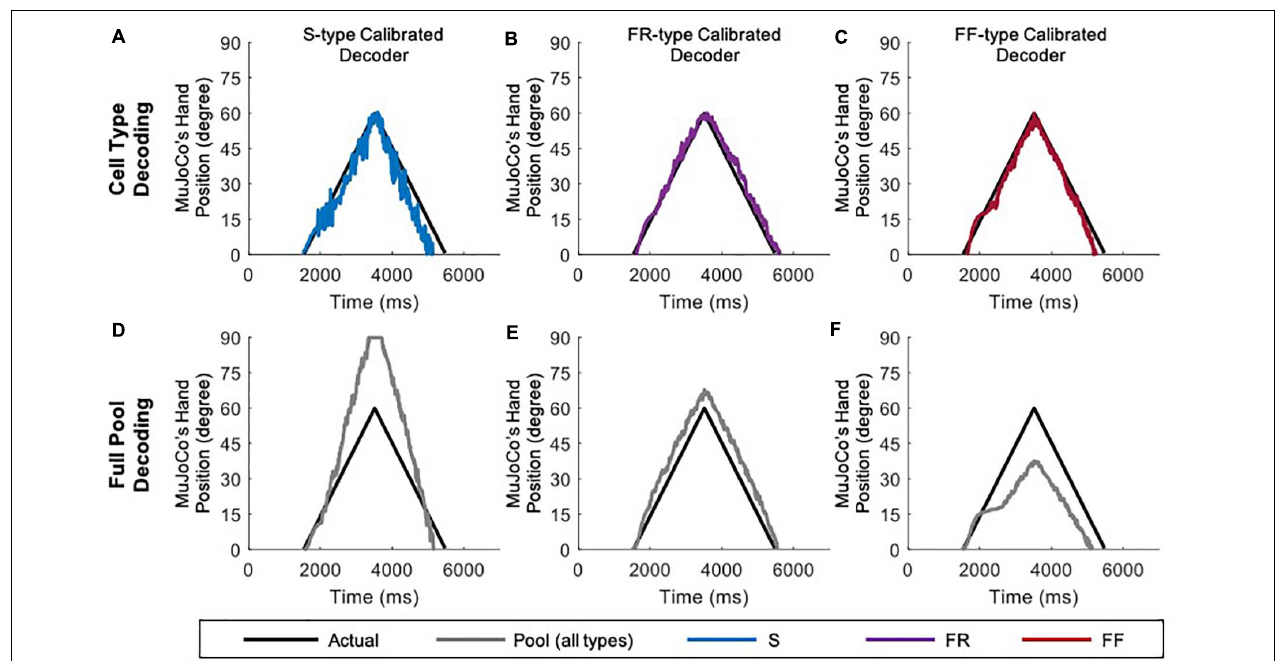
FIGURE 3 | Performance of cell-type calibrated decoders in response to a triangular ramp with rate of rise and fall of 4 nA/s. S-type calibrated decoder tested on the firing of S MNs only (A) and on aggregate pool firing (D) . FR-type calibrated decoder tested on the firing of FR MNs only (B) and on aggregate pool firing (E) . FF-type calibrated decoder tested on the firing of FF MNs only (C) and on aggregate pool firing (F) .